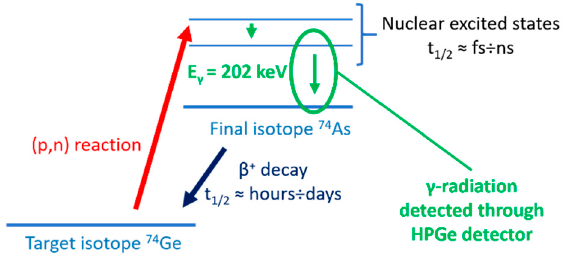
Figure 2. Scheme of the nuclear reaction studied. Prompt γ -radiation from the low-lying 202 keV state of 74 As is measured through the HPGe detector to determine online the 74 As production rate.